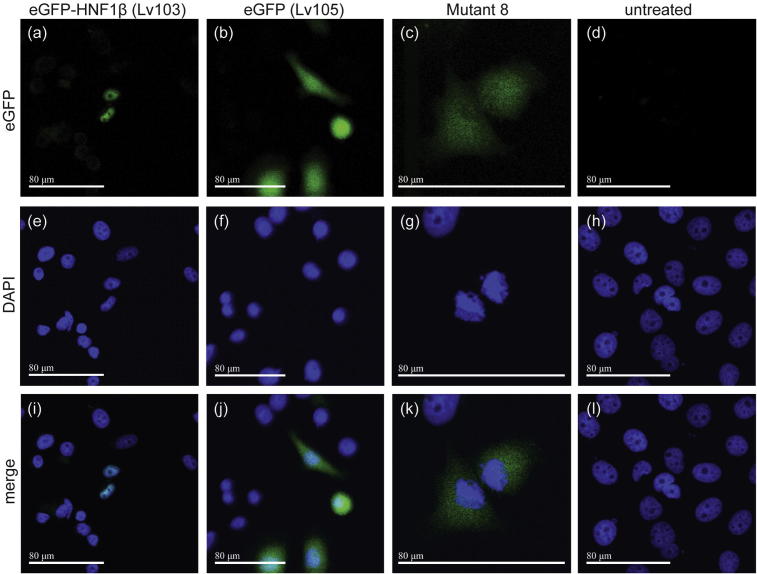
eGFP imaging of PEO1 transduced lines with (a) eGFP-HNF1β (Lv103) showed primarily nuclear localisation of the GFP signal, whereas cells transduced with eGFP (Lv105) alone (b) showed both nuclear and cytoplasmic localisation. In cells transduced with eGFP-HNF1β (Lv103) in which the seven-residue NLS had been deleted (c, Mutant 8) the eGFP signal was mislocalized to the cytoplasm. The scale bar represents 80 μm. Images were taken on a Leica tandem confocal microscope using 20×, 40× and 60× objectives.